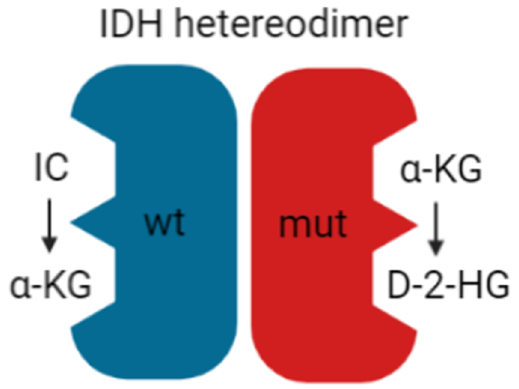
Figure 4. IDH heterodimer. IDH wild-type (wt; blue ) and mutant (mut; red ) monomers form a catalytically active heterodimer. IDH wt converts isocitrate (IC) to α -KG while IDH mut converts α -KG to D-2-HG.